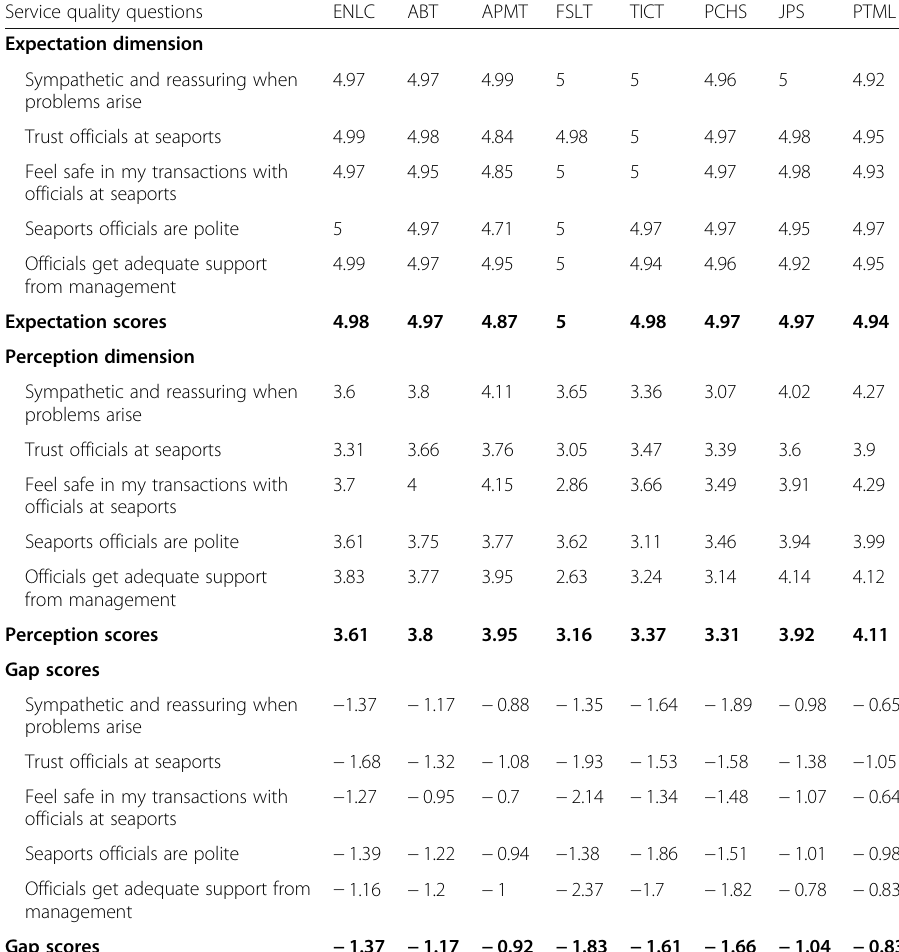
Table 7 Service quality expectation and perception average scores for assurance Service quality